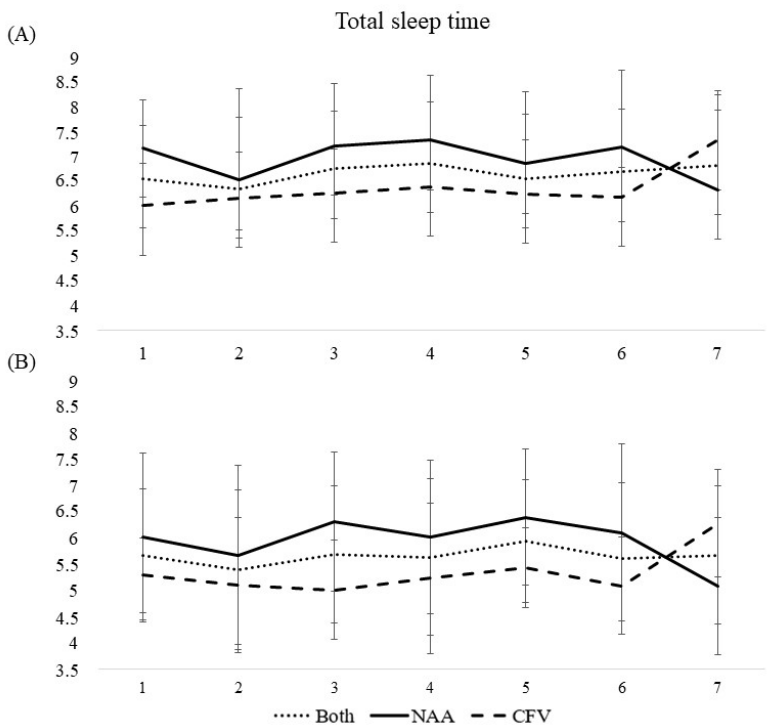
Figure 4. Mean scores of total sleep time during a 7-day workweek among pilots in the Norwegian Air Ambulance (NAA; n = 25), Christophorus Flugrettungverein (CFV; n = 22), and both groups collapsed, measured by ( A ) sleep diary and ( B ) actigraphy. Error bars represent standard deviation.